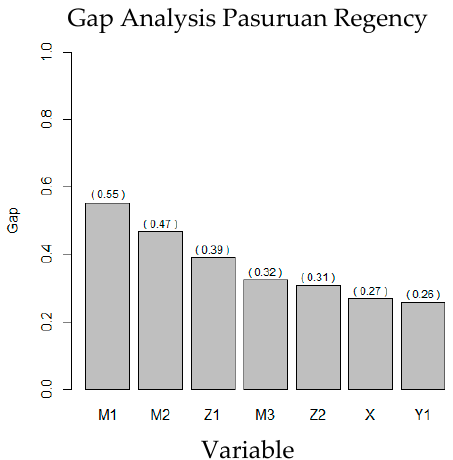
J. Open Innov. Technol. Mark. Complex. 2020 , 6 , x FOR PEER REVIEW Figure A5. Bar Diagram of Gap Analysis of Pasuruan Regency. Figure A5. Bar Diagram of Gap Analysis of Pasuruan Regency.